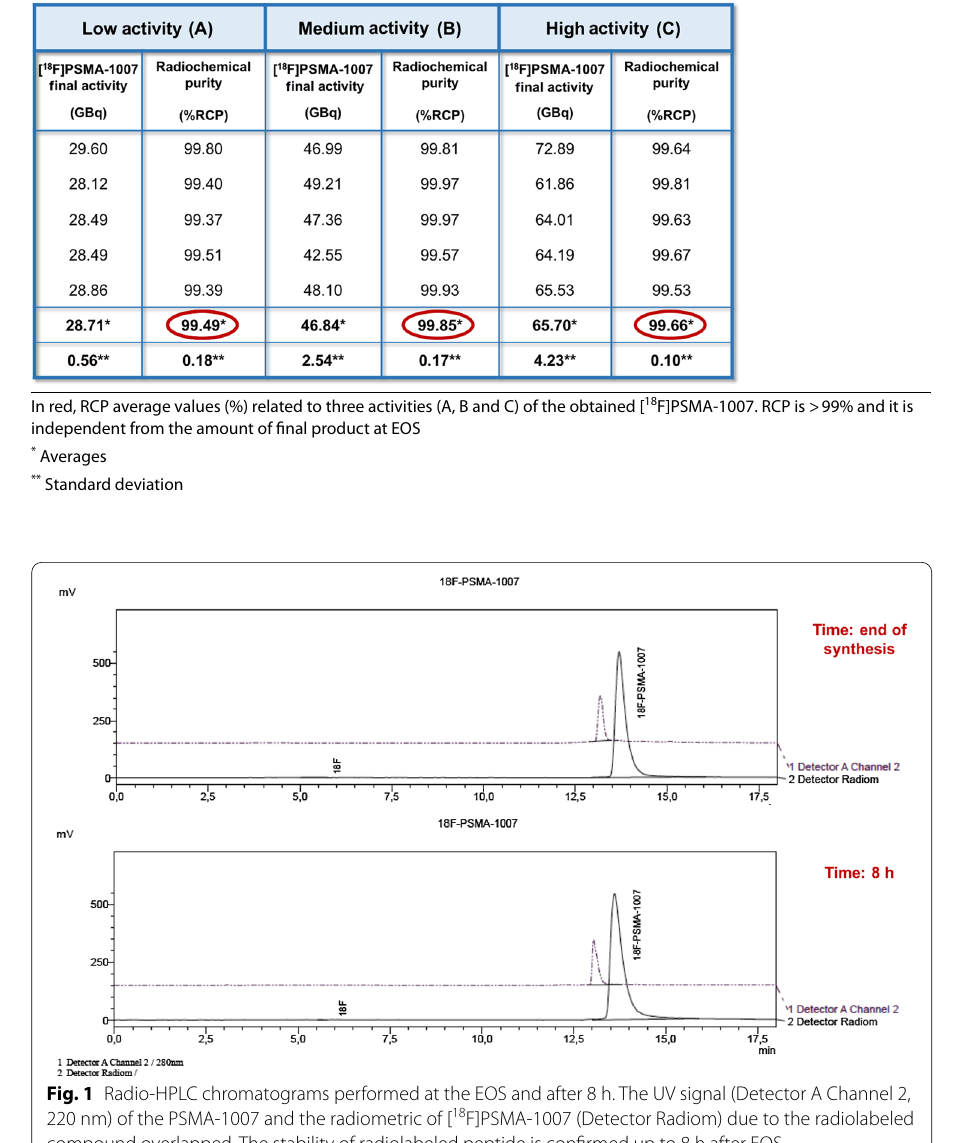
for γ-spectrometry assay and between 105 ′ and 115 ′ for half-life measurement. The endotoxin value was less than 2.5 EU/mL.